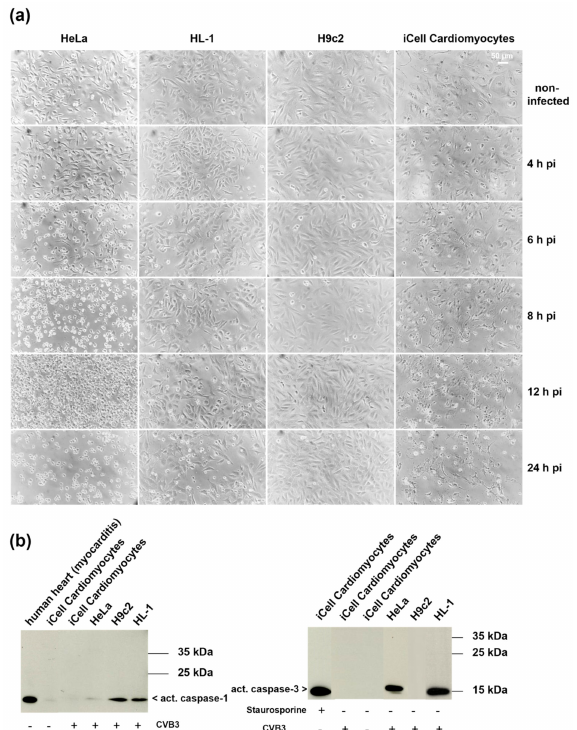
Figure 4. ( a ) Course of CVB3 infection in different cell lines. Brightfield images of CVB3-infected HeLa cells, HL-1 cells, H9c2 cells and iCell ® Cardiomyocytes. Cells were infected with MOI 10 and observed for 24 h. ( b ) Western blot analysis of caspase-1 (left panel, positive control: lysate of human heart tissue of a patient with myocarditis) and caspase-3 cleavage (right panel, positive control: iCell Cardiomyocytes treated with staurosporine) in different CVB3-infected cell lines eight hours pi (MOI